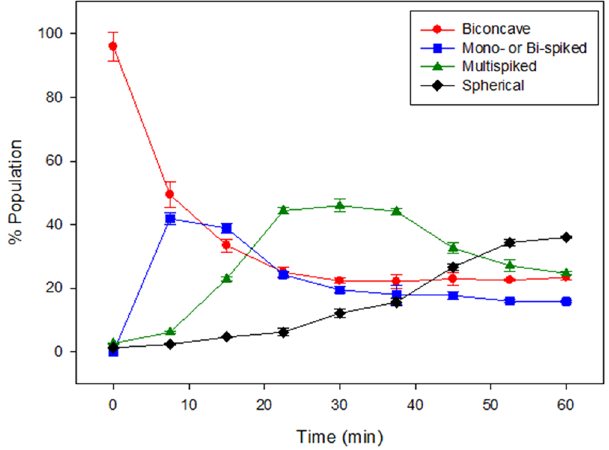
Figure 5. Quantitation of morphologies of RBC during 1 h Pb 2 + 10 µ M incubation process. (n = 300–450 cells).